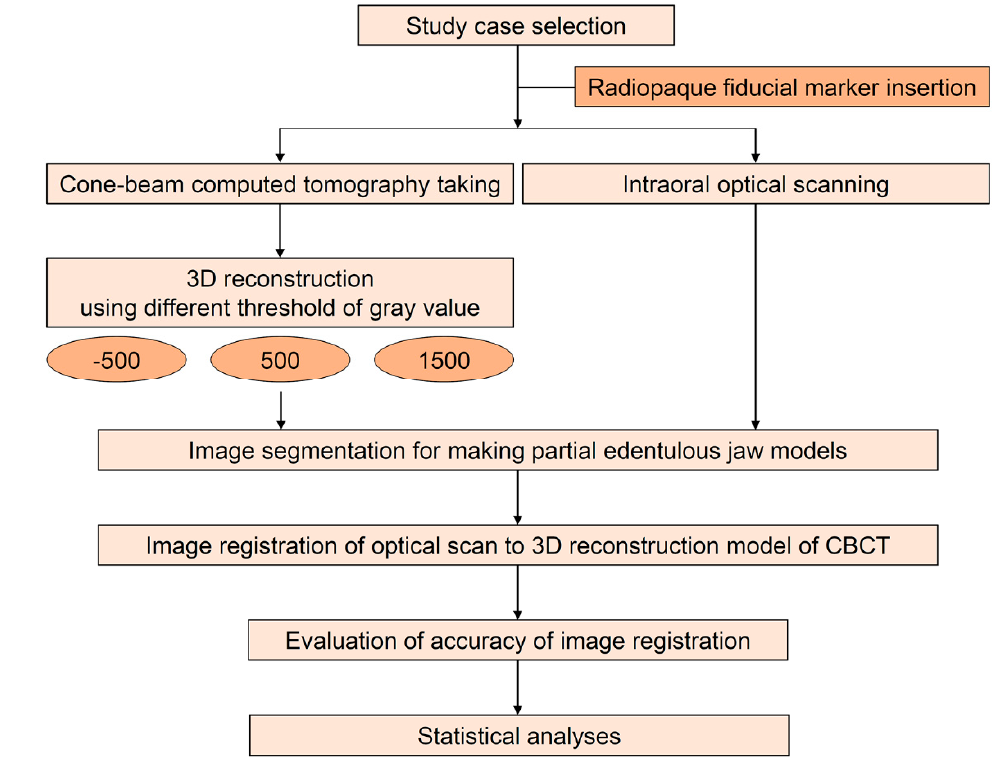
Figure 1. Study Figure 1. Study workflow.